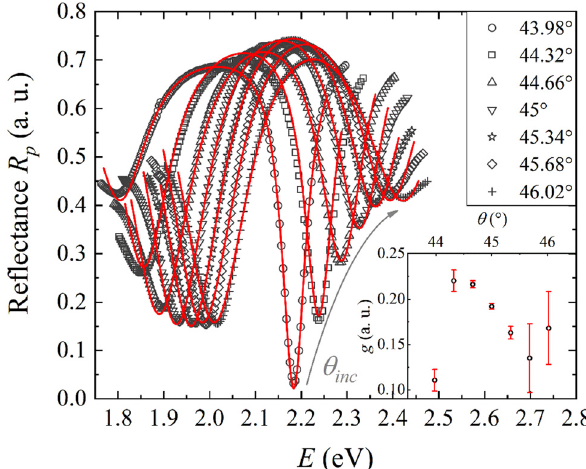
Figure 5: The hybrid TPP-SPP mode experimental (shapes) TM-polarizationreflectionspectraandthose calculatedbyusingthe expression 4 (solid red line) curves. The inset on the bottom right shows the values of the coupling parameter g and its error